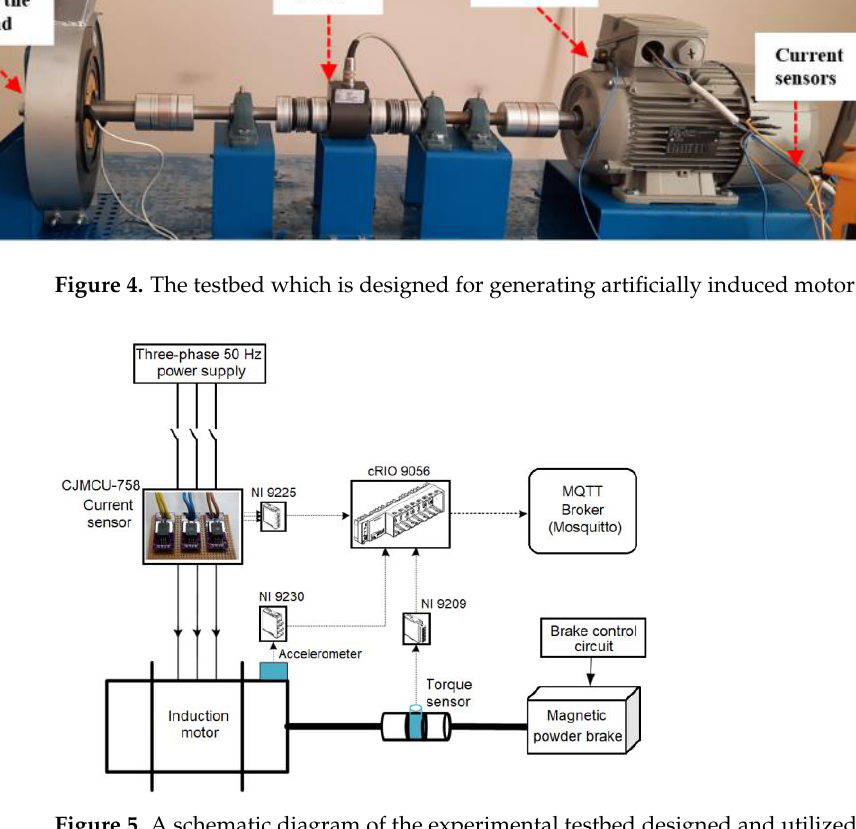
Figure 6. The real-time multisensory fault diagnosis. For online data collection, an end-to-end data pipeline is designed and implemented. Figure 7 illustrate the main components of the architecture. The data acquisition module collects and buffers sensor data in memory on temporary local storage files. MQTT data transfer protocol transports data in topics via pub/sub protocol. A separate topic is created for each sensor type, and an MQTT client that runs in edge devices such as cRIO publishes the sensor data in batches through the topics on the MQTT broker program called Mosquitto broker. After the current batch is posted to the broker, the data are wiped programmatically to free up the space for upcoming motor operations data collection.